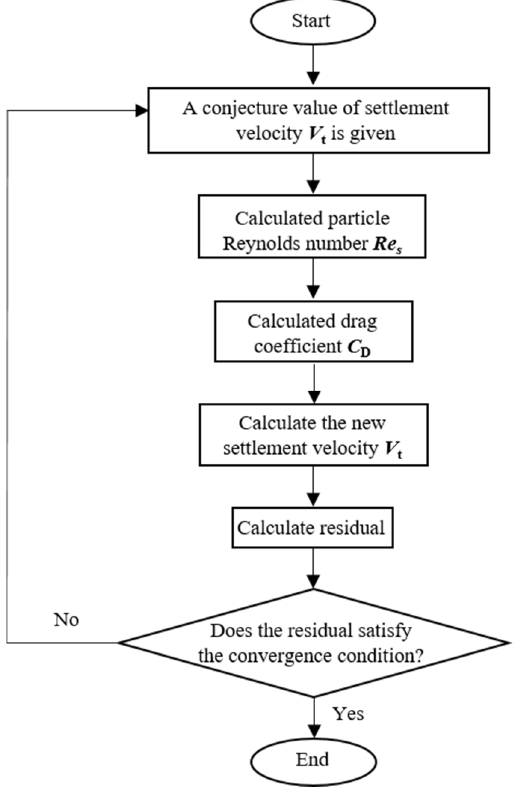
Figure 8. Iterative trial and error flow chart.